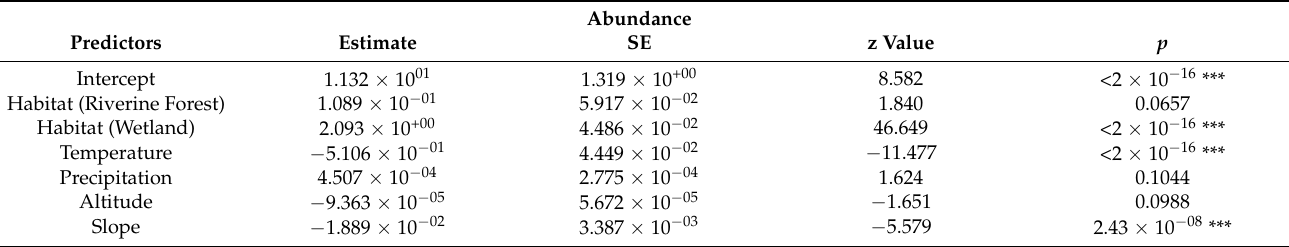
Table 6. Summary statistics for General Linear Model (GLM) for abundance relationships with selected environmental variables for frog species.